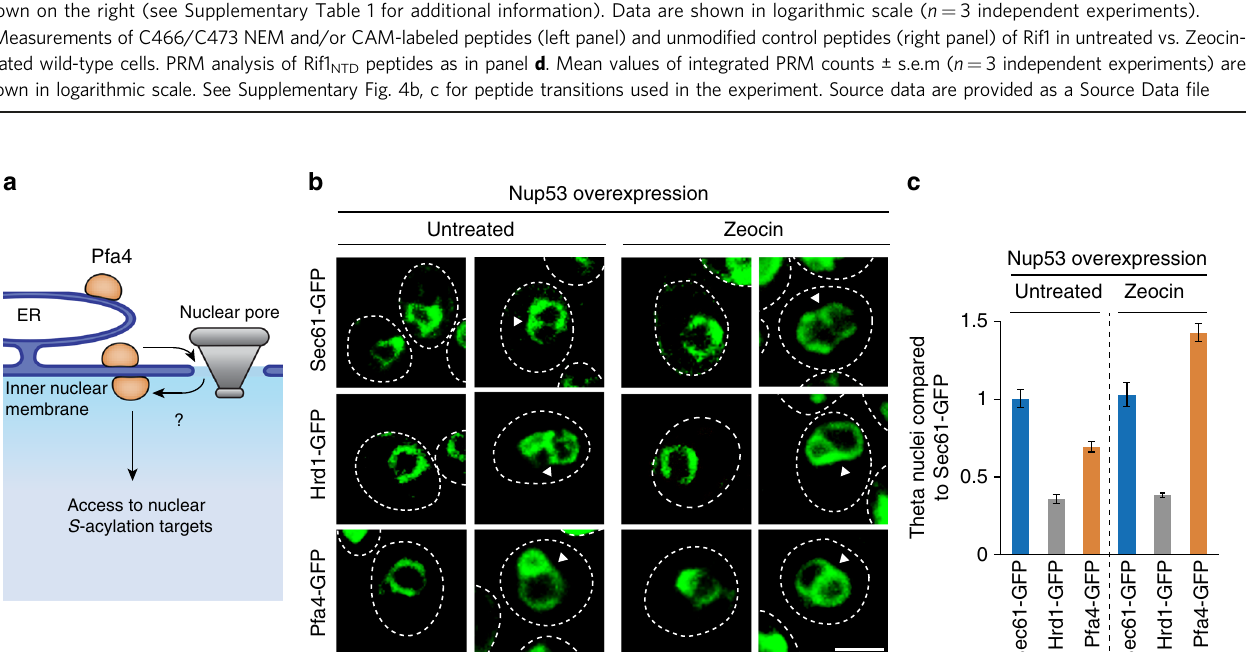
The PRM values for double NEM-modi fi ed Rif1 peptides spanning residues 463 to 479 are ~10 times higher than the values for peptides derived from Rif1 S -acylated at C466 or C473. This implies that a substantial fraction of 15 – 20% of Rif1 was S -acylated at either C466 or C473 in wild-type cells (Fig. 4d). DNA-damage treatment with Zeocin did not lead to gross changes in Rif1 S- acylation levels (Fig. 4e), consistent with constitutive Rif1 S- acylation.